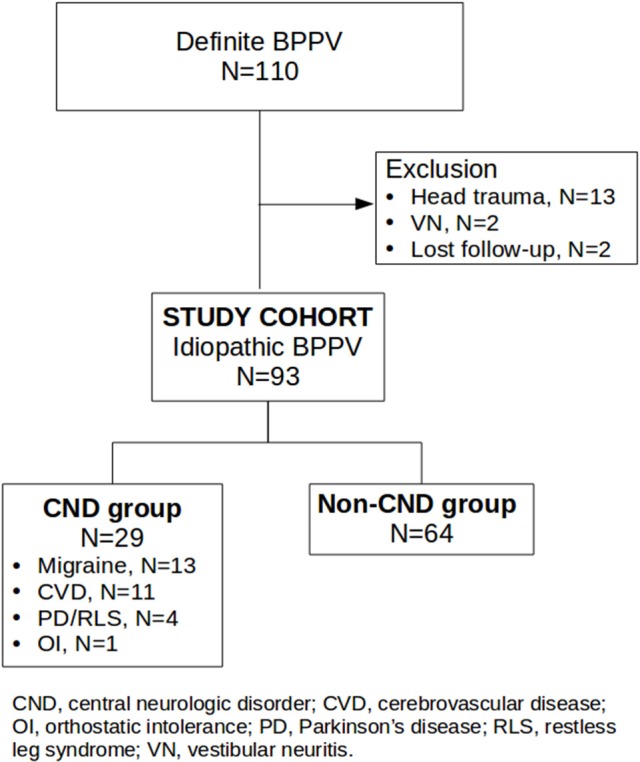
Flow chart of candidate recruitment and categorization. The study cohort comprised 93 idiopathic BPPV cases. The CND group comprised 29 cases, 13 with migraines, 11 with cerebrovascular disease, three with PD, one with restless leg syndrome, and one with idiopathic orthostatic intolerance. The non-CND group comprised 64 cases.